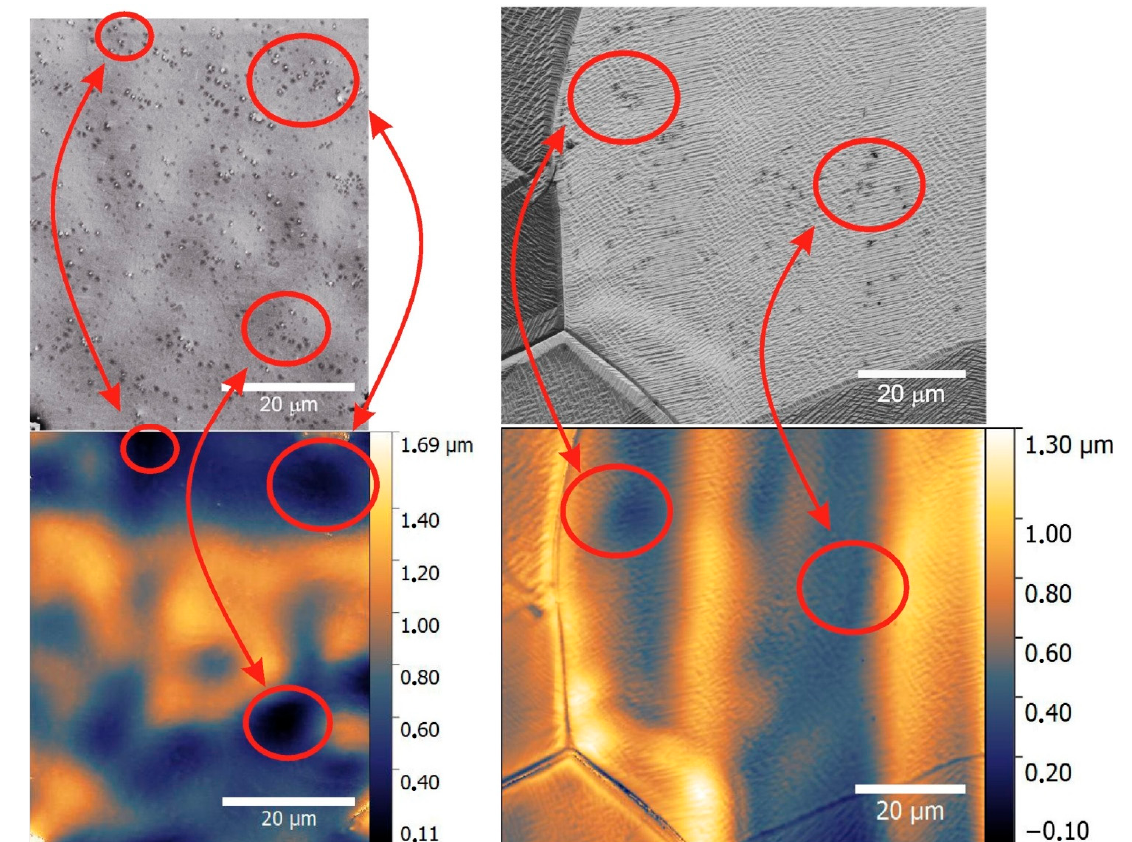
Figure 4. Upper row — SEM images of graphene films on copper foils. Low row — Interference profilometry images of the same areas of graphene film on copper foils. The left column corresponds to copper foil treated in nitric acid. The right column corresponds to copper foil treated by electrochemical polishing.